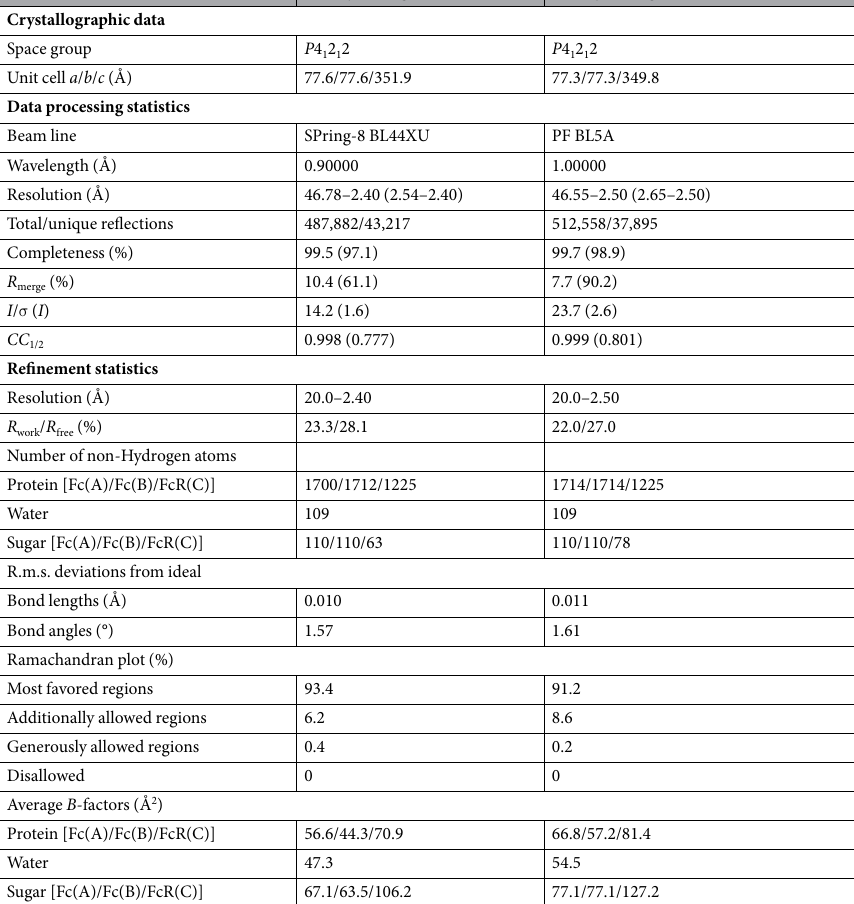
Table 2. Data collection and refinement statistics for the fucosylated IgG1-Fc/sFc γ RIIIa